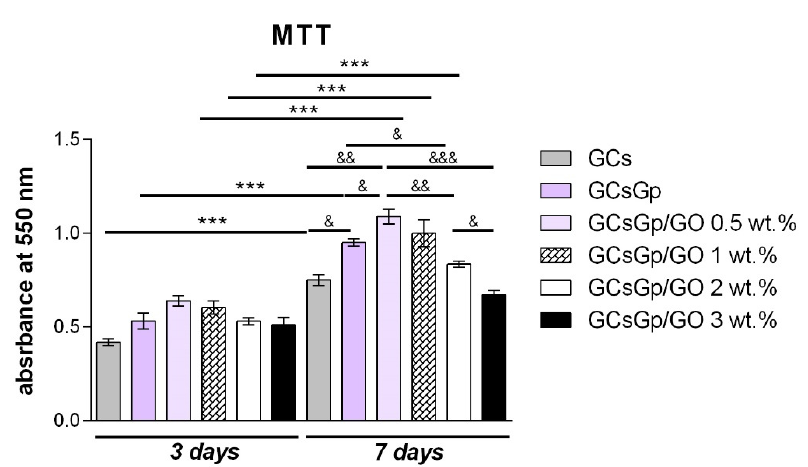
Figure 5. Murine preosteoblasts viability and proliferation profile as resulted from quantitative evaluation by MTT assay after 3 and 7 days of in vitro cell culture. Statistical significance: &— p < 0.05; &&— p < 0.01, *** and &&&— p < 0.001 (“*” was used to compare the viability and proliferation profile